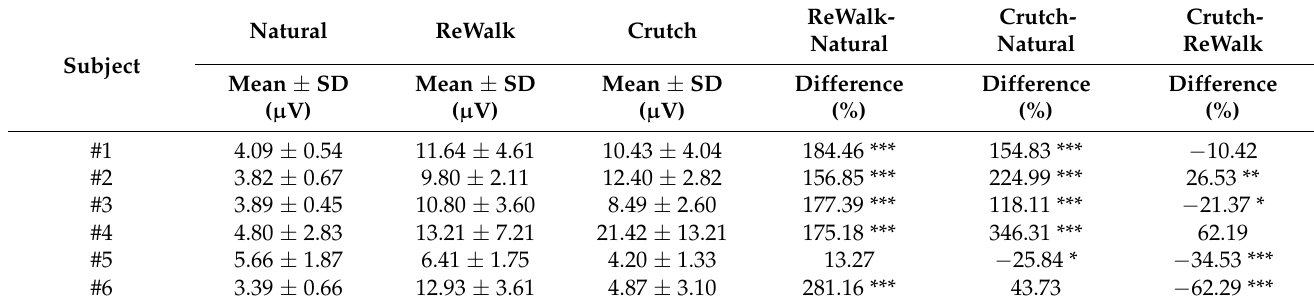
Table 4. Comparison of mean SL EMG WL during the WA